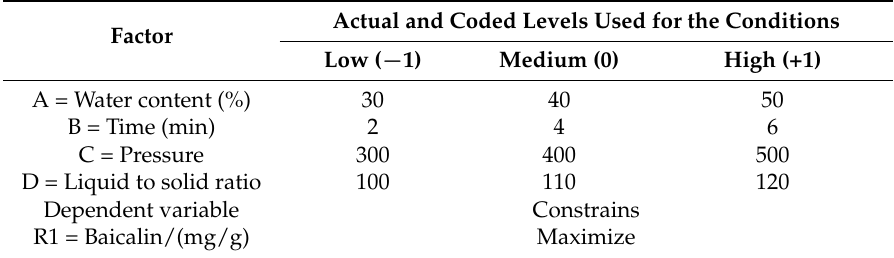
Table 3. Variables in the Box-Behnken design.